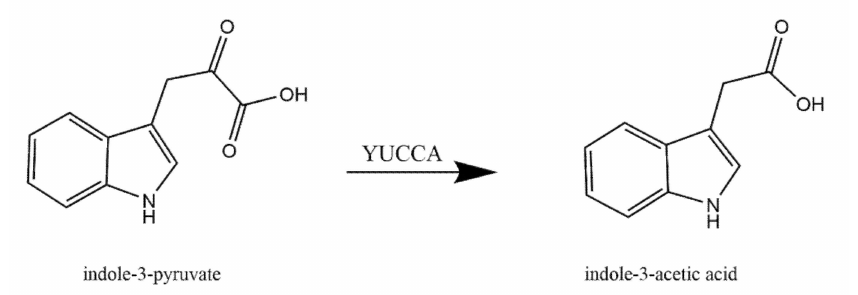
Figure 9. Conversion of indole-3-pryuvate to indole-3-acetic acid catalyzed by indole-3-pyruvate monooxygenase